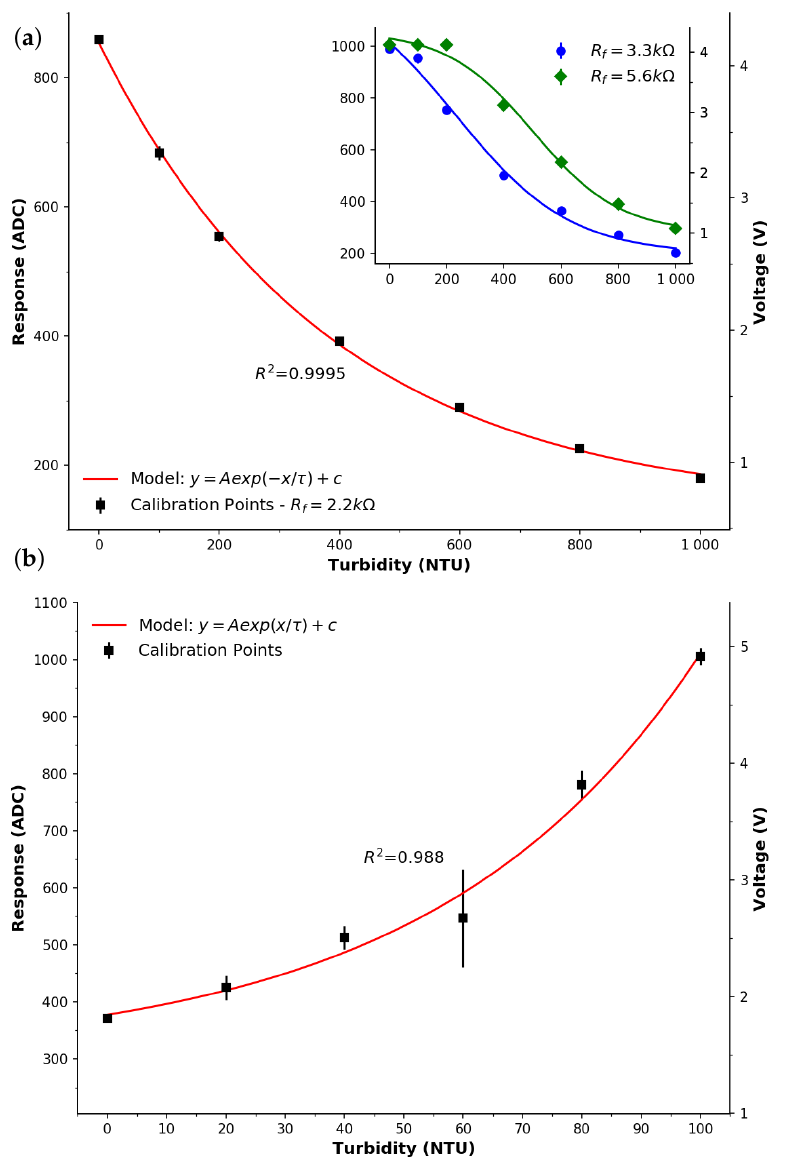
Figure 3. Response of the photodiode implementation. Points represent the average of successive measurements, error bars the standard deviation. ( a ) Photodiode facing the emitter ( R f = 2.2 k Ω , (cid:4) ). The line represents a good exponential fit ( R 2 = 0.9995, y = Ae − x / τ + c ). Inset—response plots with larger feedback resistors ( (cid:108) 3.3 k Ω , (cid:7) 5.6 k Ω ) on the op-amp, where the lines represent a sigmoid fit. ( b ) Photodiode placed orthogonal to the emitter. The line represents a good exponential fit ( R 2 = 0.988, y = Ae x / τ + c